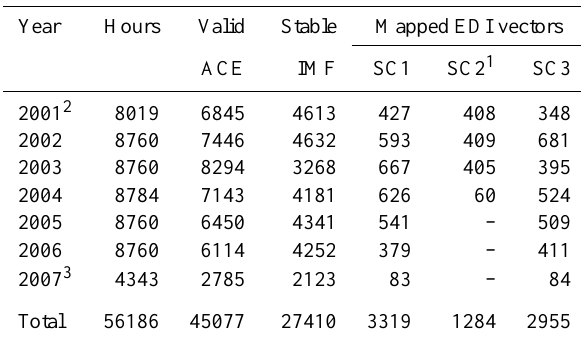
Table 1. Data coverage in hours of ACE and Cluster measurements used in the present